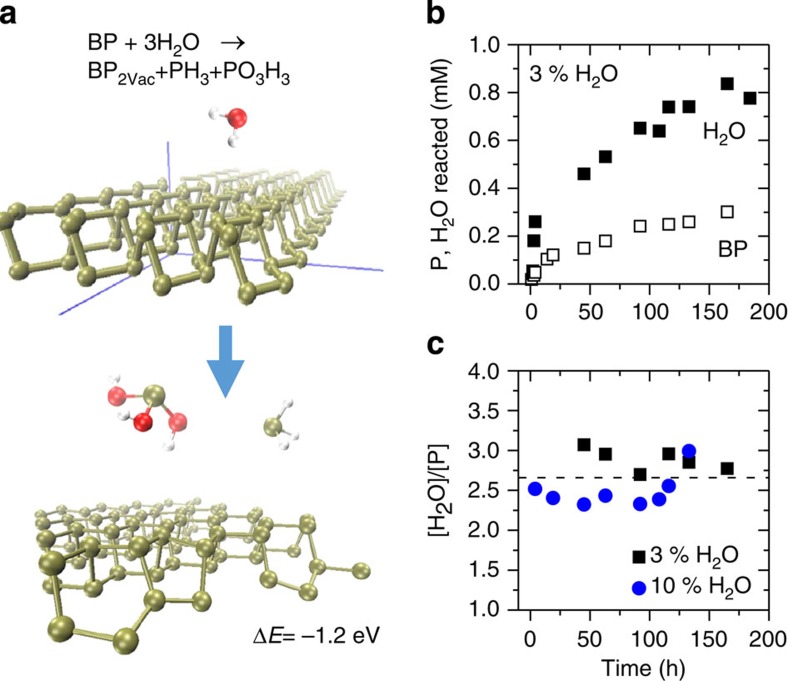
Reactivity of solvent-stabilized Black Phosphorous with water.(a) Edge selective degradation model for BP exposed to pure neutral water. Top and bottom panel represent reagent (BP edge+three water molecules) and reaction products (BP defective edge+phosphine+phosphorous acid), respectively, with the reaction energy also given. Green, red and white balls represent P, O and H atoms, respectively. (b) Experimental data for amount of reacted phosphorus and water, respectively, as a function of time for std-BP GB in CHP after addition of 3 vol% of water. The data was obtained from tracking both water and BP concentrations by ultraviolet–visible spectroscopy (see Supplementary Note 3). (c) Molar ratio of water/BP as a function of time measured for a std-BP GB dispersion in CHP after addition of 3 and 10 vol% of water. The molar ratio is centred at 2–3, which is reasonably consistent with the proposed edge degradation reaction.